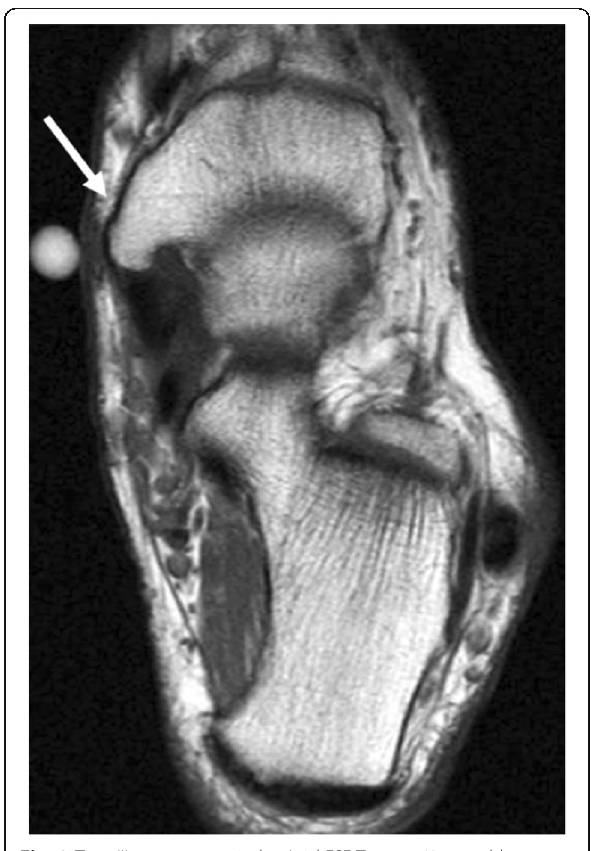
Fig. 3 Type III accessory navicular. Axial FSE T1 on a 60-year-old man with pain in the medial aspect of the foot, over the bony prominence of a type III accessory navicular (white arrow). Note a region of decreased signal and trabeculation of the subcutaneous fat over the prominence of the tuberosity (vitamin A marker). This suggests a degree of irritation of the surrounding tissues due to